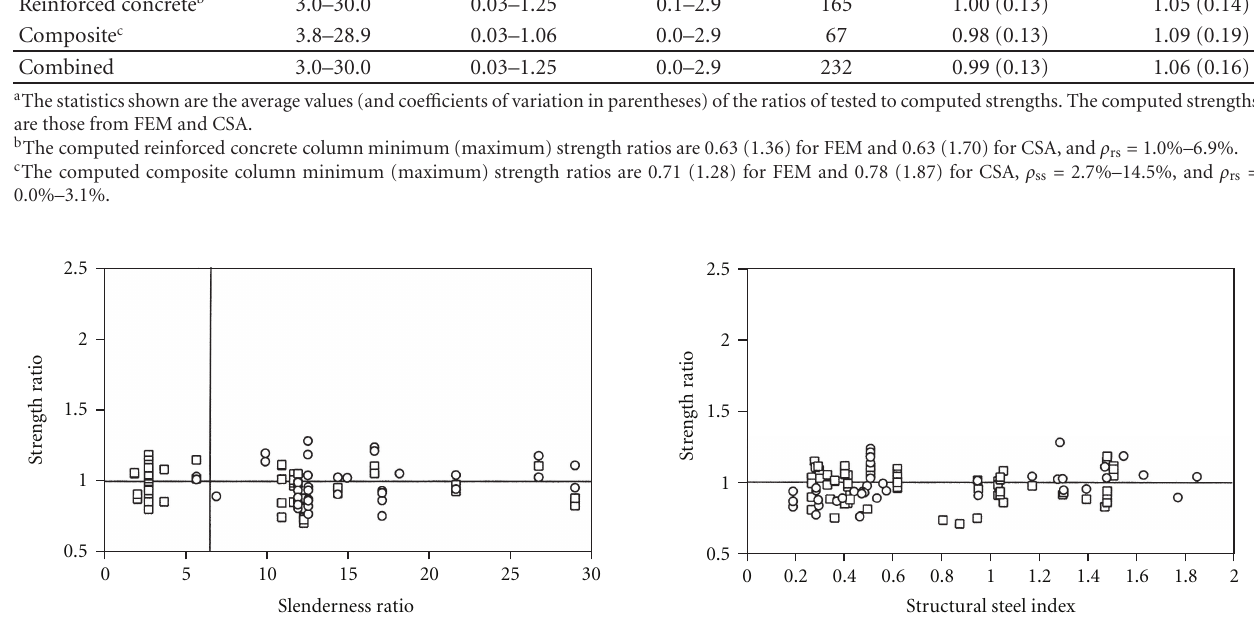
Figure 11: E ff ect of slenderness ratio (cid:2)/h on FEM strength ratios for composite columns ( n = 111).